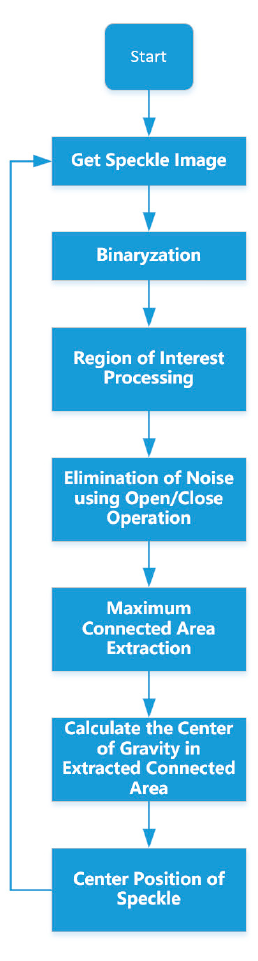
Figure 5. Flow chart of image processing algorithm.